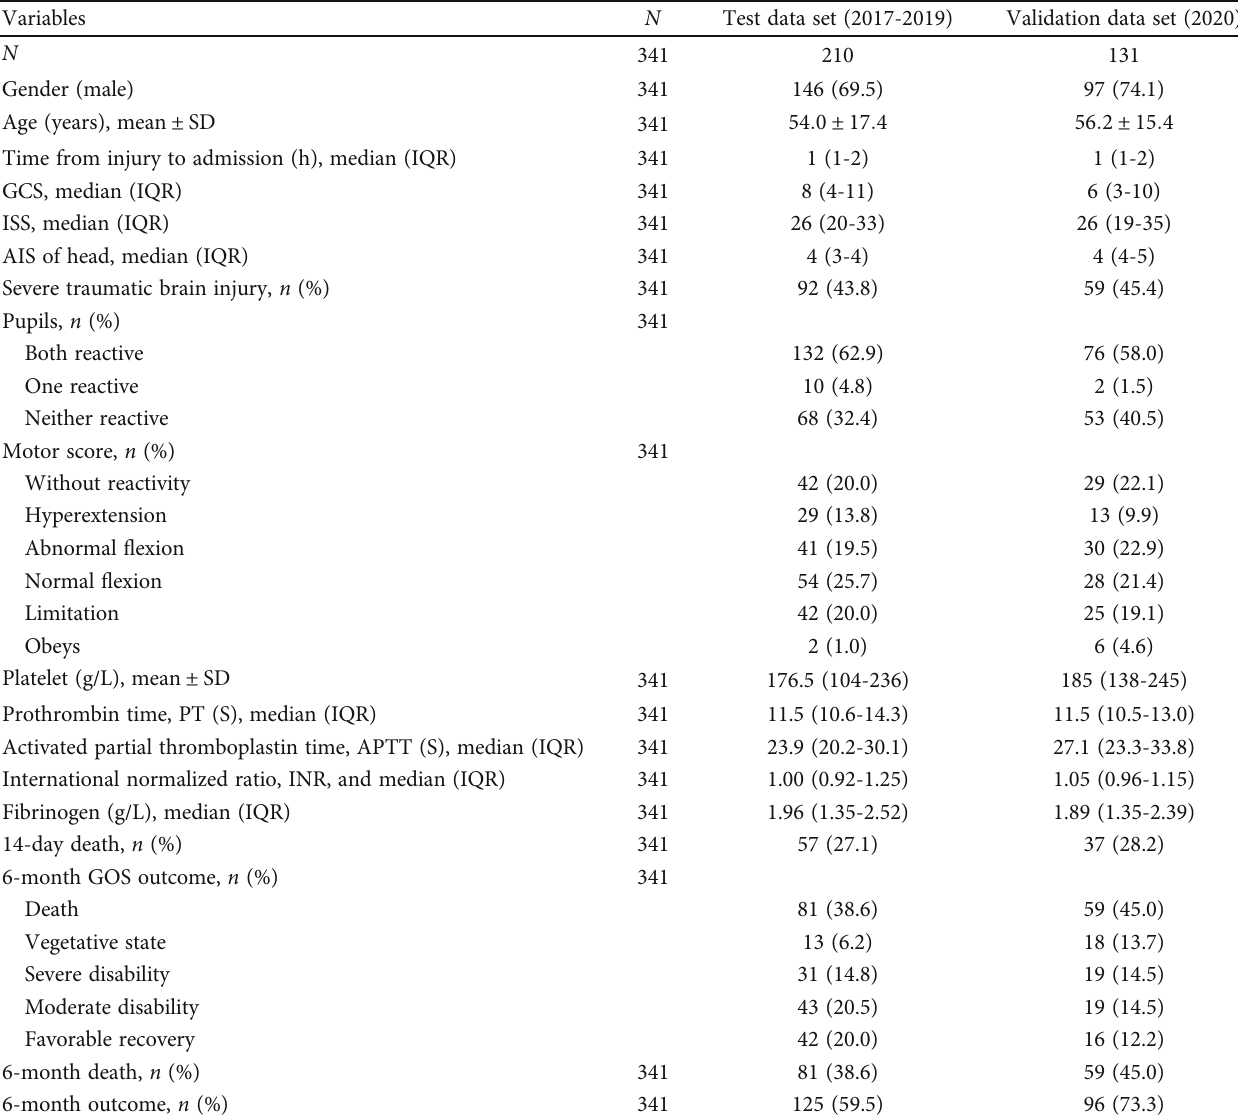
Table 1: Basic information.